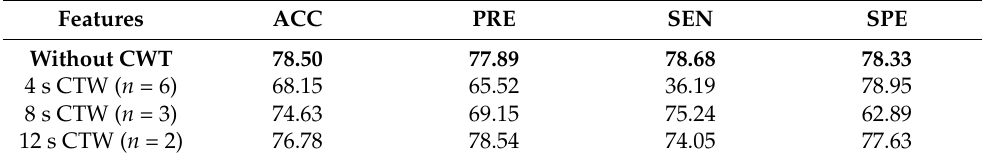
Table 7. AF detection performance based on energy features with and without CTW by means of